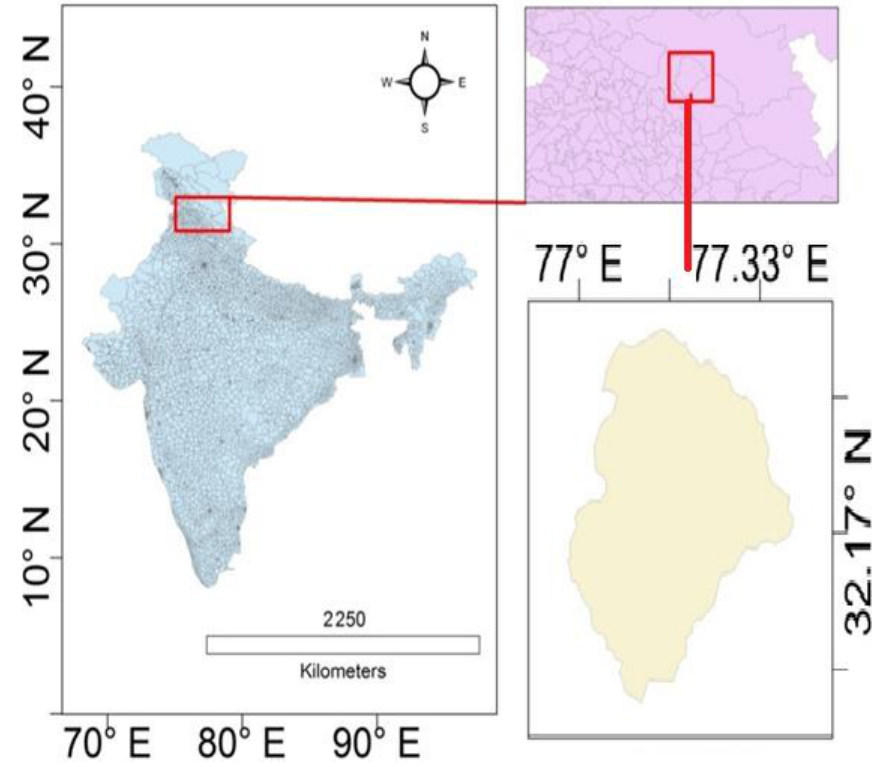
Figure 3. Geographical location of Manali, Himachal Pradesh, India.